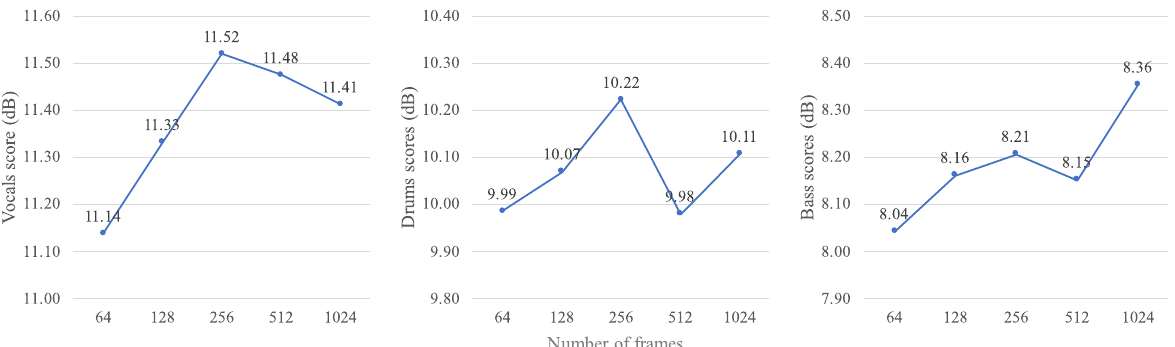
Fig. 4 The average score of SDR, SIR, and SAR on “vocals,” “drums,” and “bass” categories with different input audio lengths